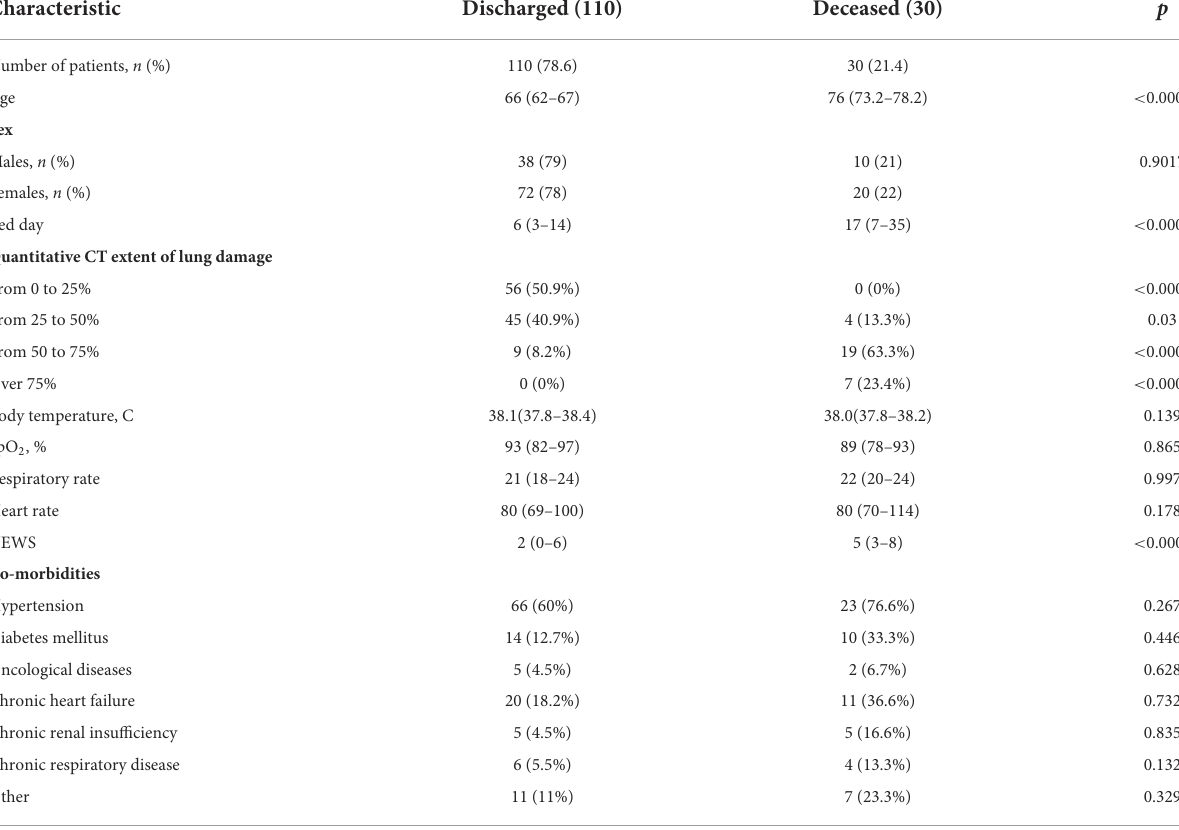
TABLE 1 Clinical and demographic characteristics of patients.